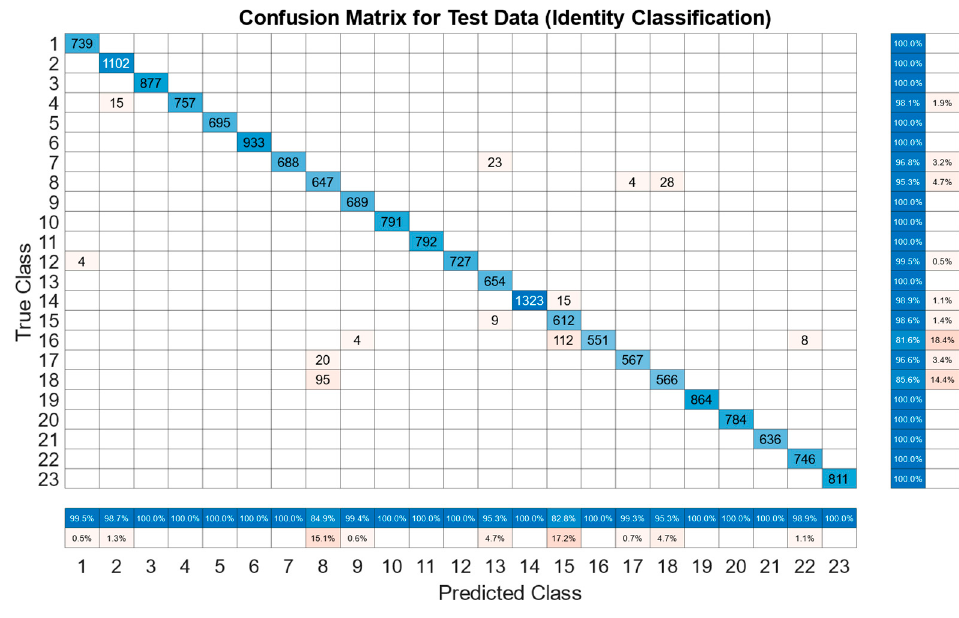
Figure 10. Identity Classification using Final BLSTM Model.